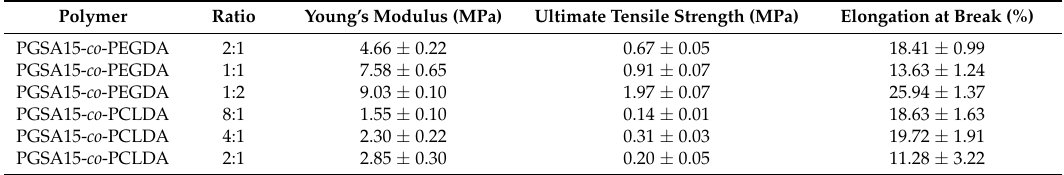
Table 4. Mechanical properties of DLP-AM printed PGSA15- co -PEGDA and PGSA15- co -PCLDA in various weight ratio ( n =